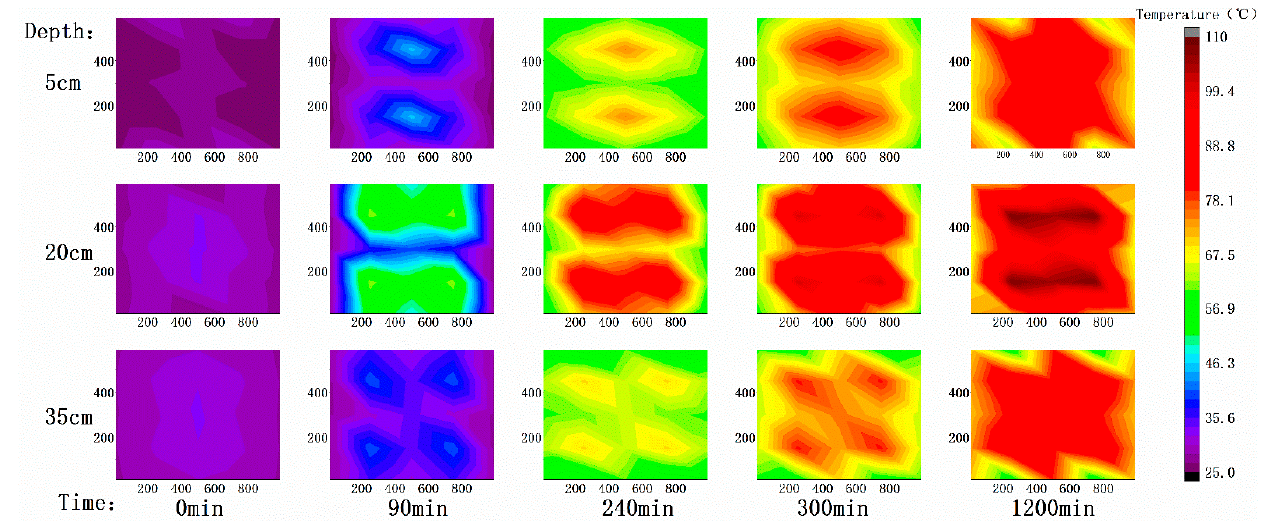
Figure 2. Isotherm map at 0, 90, 240, 300, 1200 min.